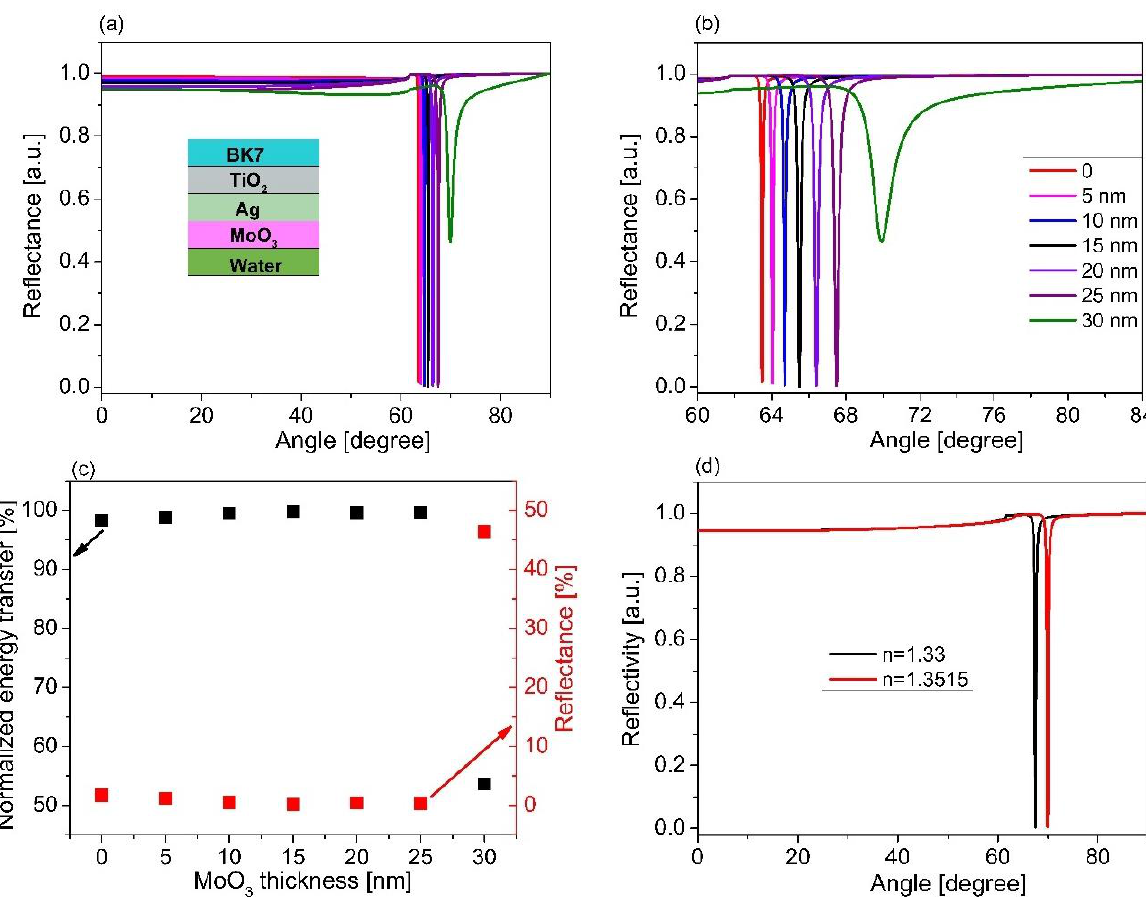
Figure 9. SPR spectra for varying thicknesses of MoO 3 based on the sensor structure of the BK7/TiO 2 /Ag/MoO 3 /sensing medium; ( b ) magnified view of ( a ); ( c ) the relationship between energy transfer and the MoO 3 thickness; ( d ) the change in resonance for different RI of the sensing medium based on the sensor structure of BK7/TiO 2 (140 nm)/Ag (60 nm)/MoO 3 (25 nm).